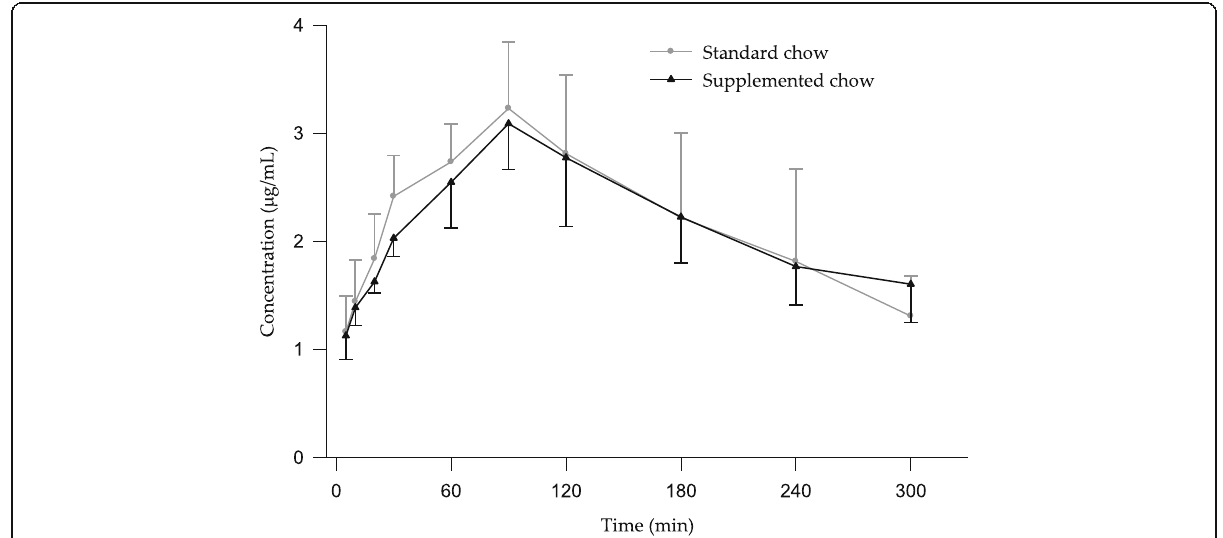
Fig. 2 Mean plasma concentrations of metformin in diabetic rabbits after the oral administration of 30 mg/kg